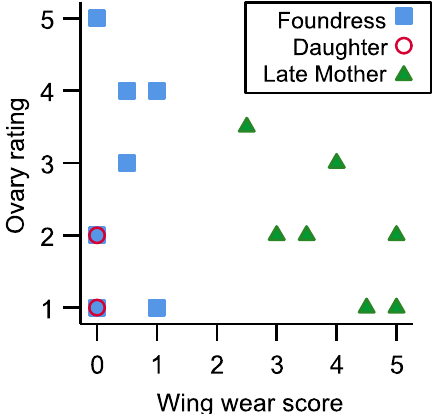
Figure 6. Ovary development plotted against wing wear; late mothers are represented by green filled triangles, foundresses by blue filled squares, and newly emerged daughters by open red circles. Note that six newly emerged daughter individuals are clustered at x = 0, y = 1. N = 7 for each